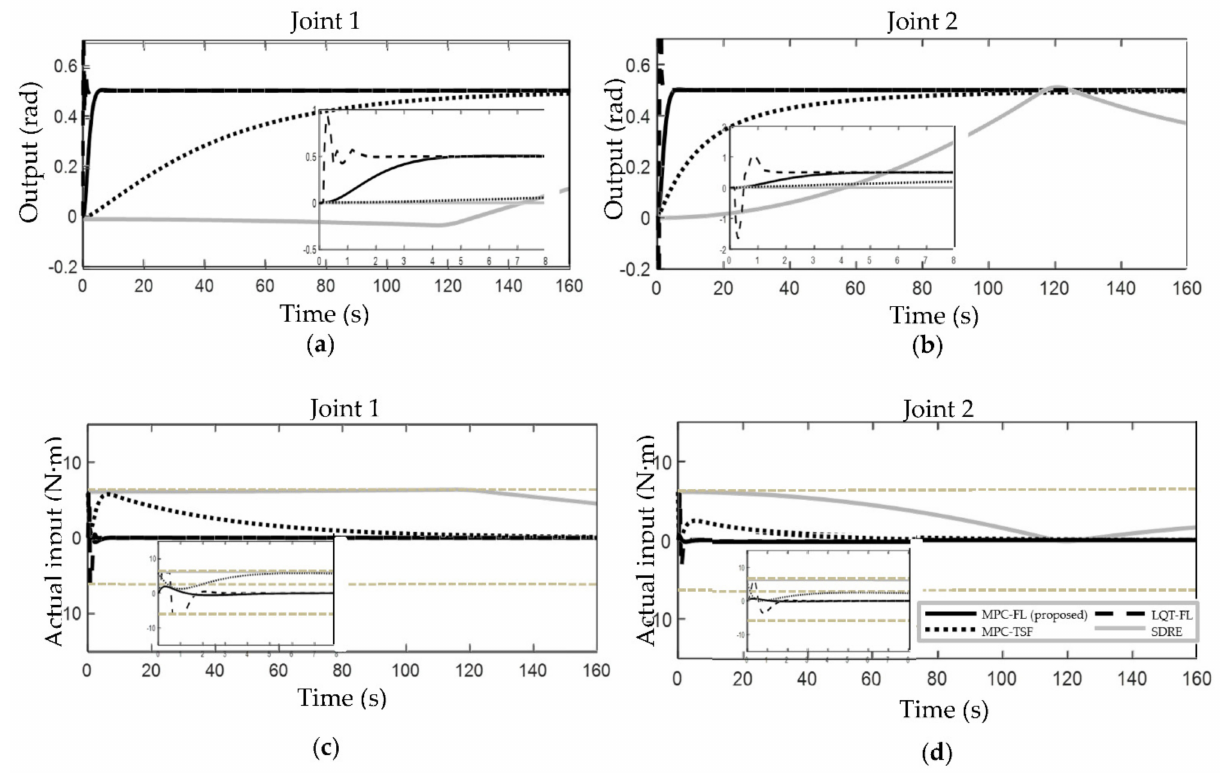
Figure 12. Two-link robot arm by applying the four control schemes with input constraints ± 6.0 N · m: ( a ) output responses of joint 1; ( b ) output responses of joint 2; ( c ) input signals of joint 1; ( d ) input signals of joint